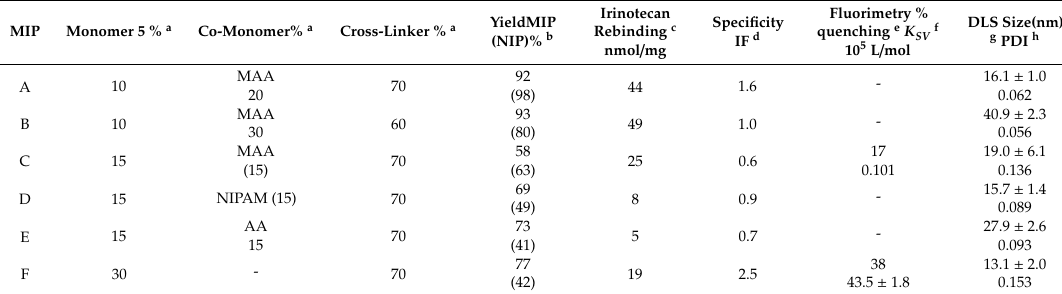
Table 2. Characterisation of the imprinted